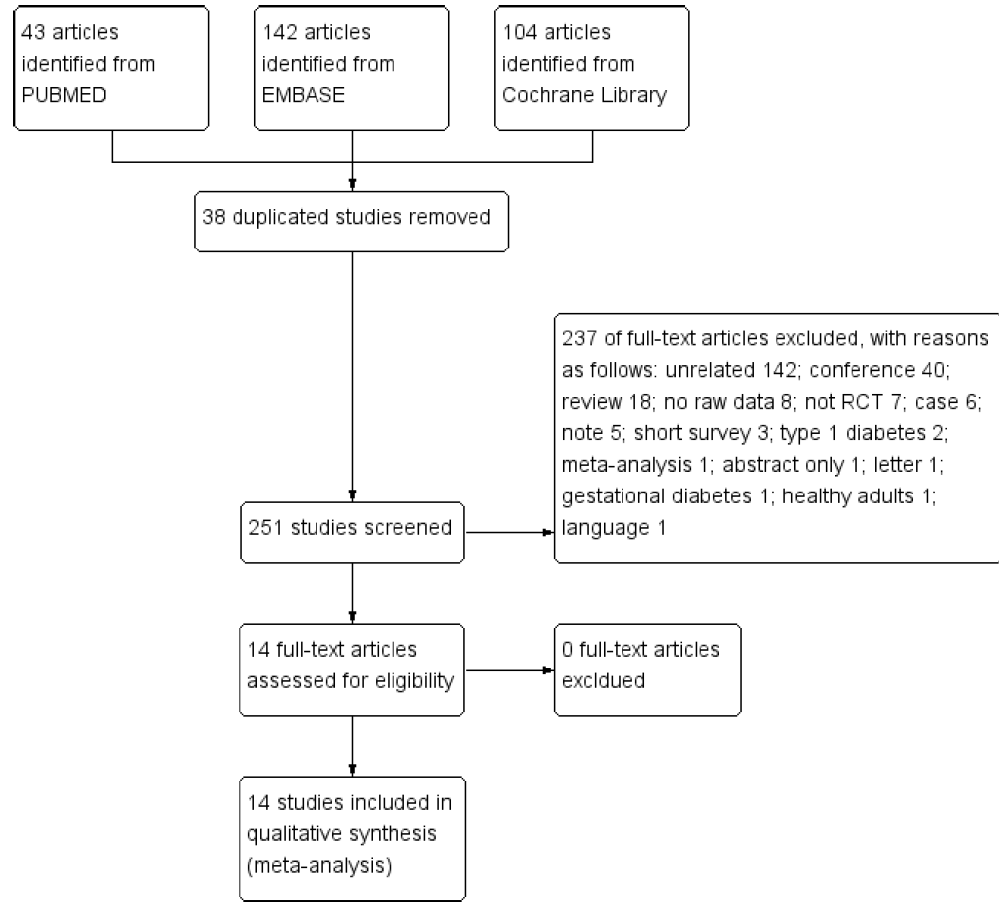
Figure 1. Study selection diagram. Abbreviation: RCT, randomized controlled trial.